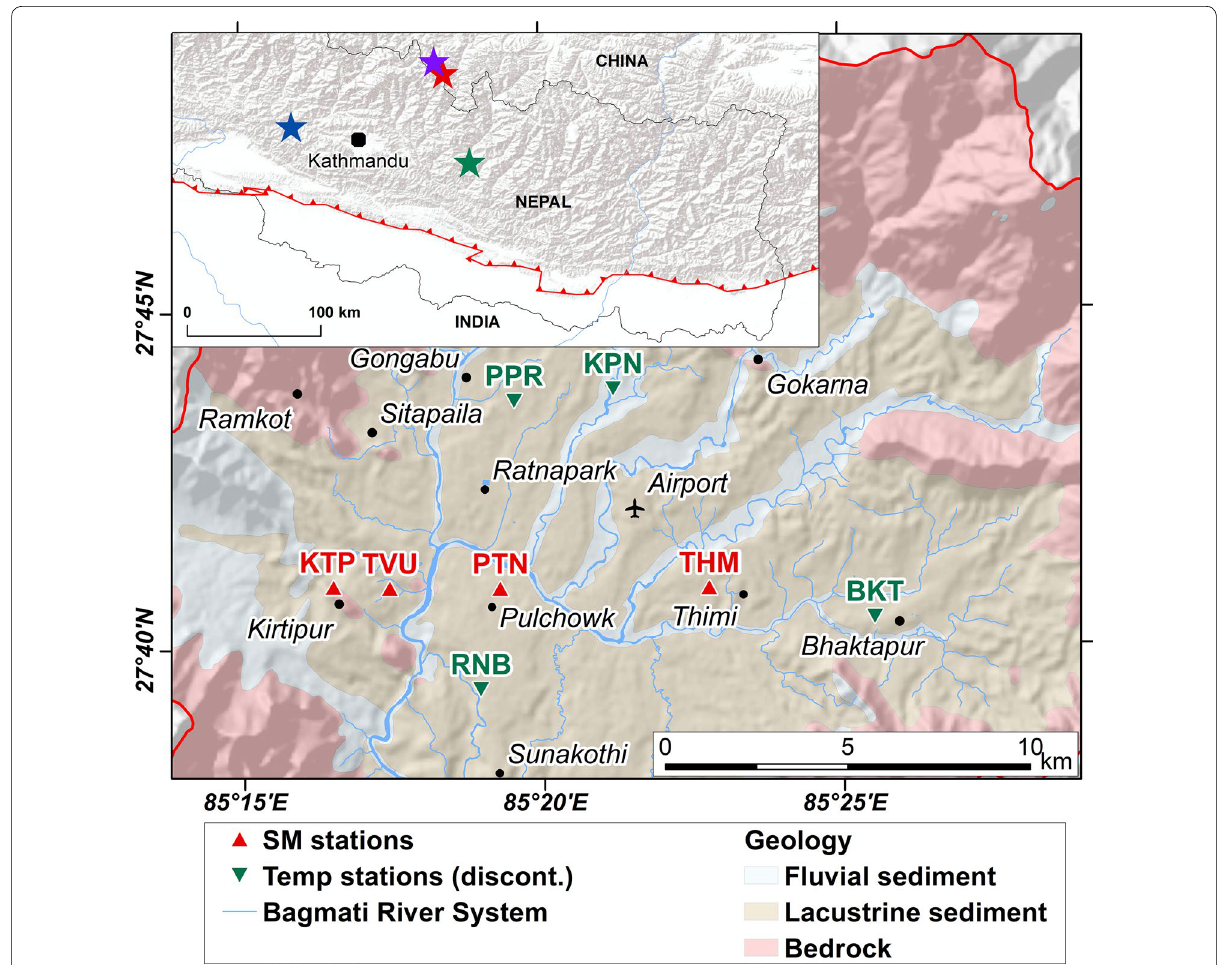
Fig. 1 Simplified geology of Kathmandu and location of strong-motion accelerometers. The temporary stations ( green triangles ) were added after the mainshock from the Gorkha Earthquake and were in operation for 3 months. Inset map of central and eastern Nepal showing the epicenters of the four earthquakes used in this study. The red star is the epicenter for the mb4.9 earthquake used to determine the 1-D models, the purple star is the epicenter for the Mw5.1 earthquake that occurred on April 25, 2015, 17:42 UTC, the blue star is the epicenter for the Mw5.1 that occurred at 23:16 UTC on the same day, and the green star is the epicenter for the Mw5.5 earthquake. The red line in the inset is the outline of the Himalayan Main Frontal